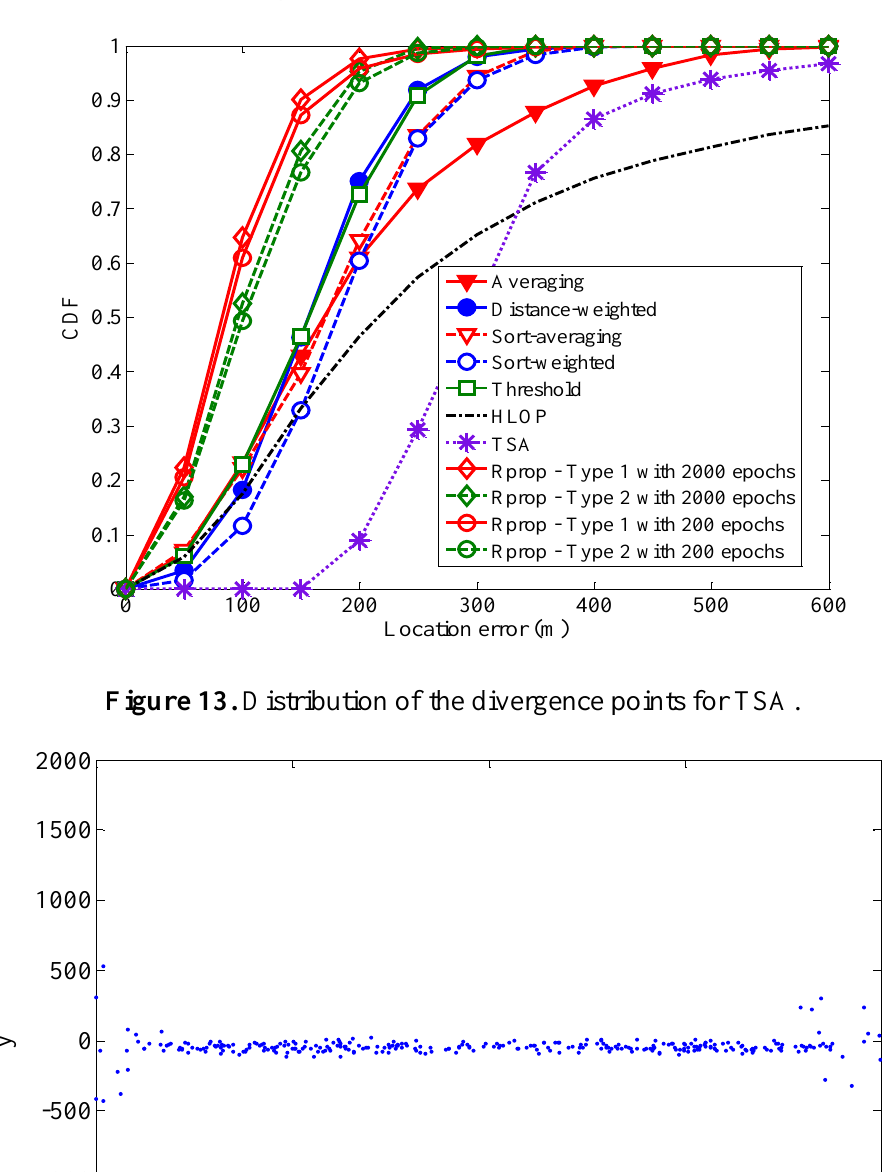
Figure 12. CDFs of the location error of the other different methods and the proposed algorithm with 2,000 and 200 epochs.